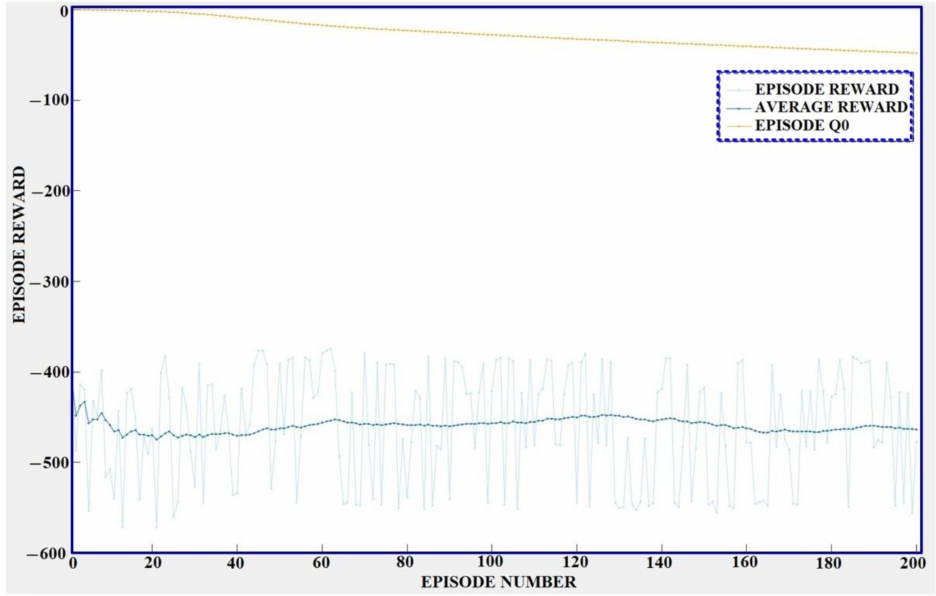
Figure 25. Training stage of the RL-TD3 agent for the correction of u dref and u qref